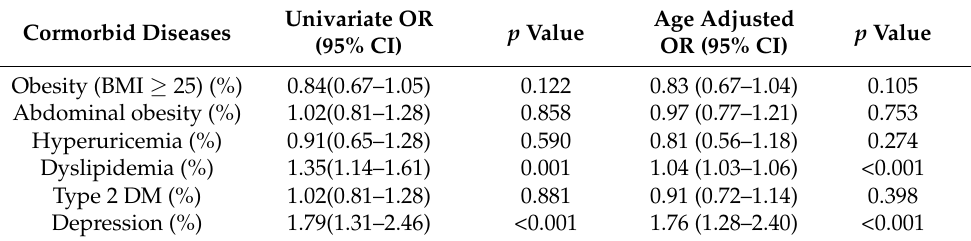
Table 5. Logistic regression analysis of comorbid diseases with osteoporosis adjusted by age in female subjects.